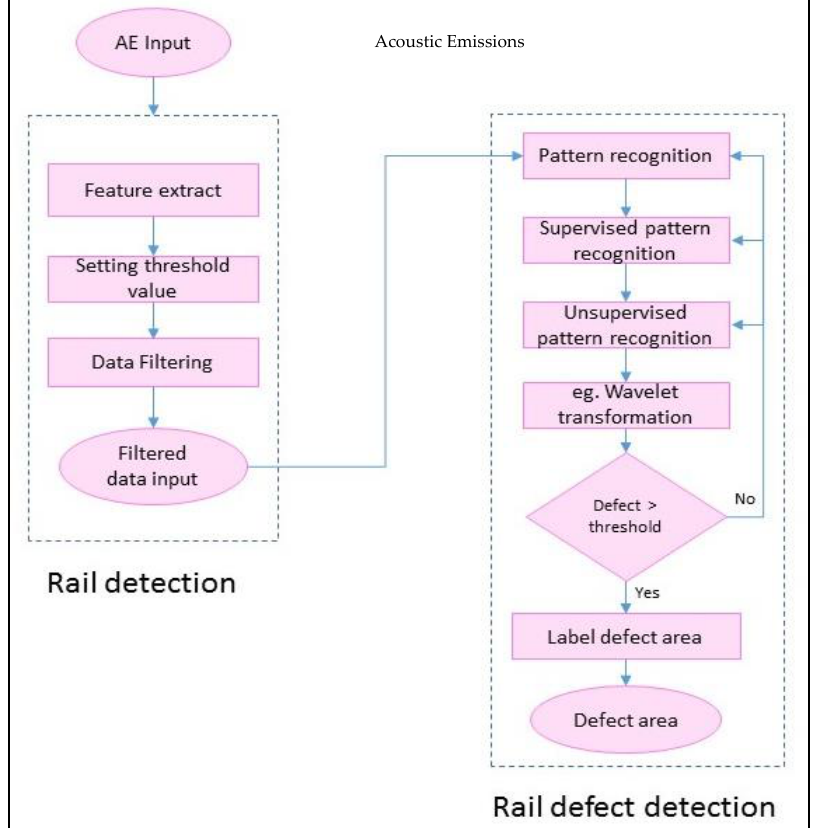
Figure 2. Broken rail detecting methodology flowchart .